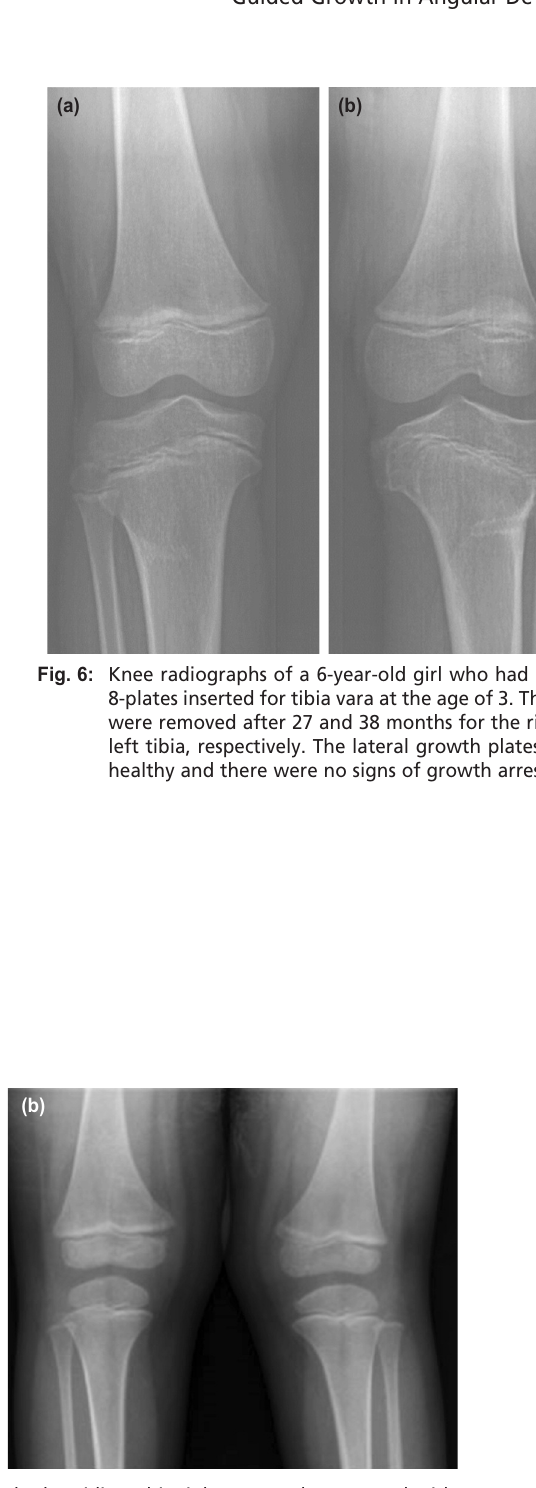
Knee radiographs of a 3-year-old boy with a BMI of 22. He had an idiopathic right genu valgus treated with a reconstruction Fig. 7: plate (Case 2). (a) Reconstruction plate inserted at distal medial femur. (b) Correction of angular deformity in the right knee was maintained, 24 months after plate removal.